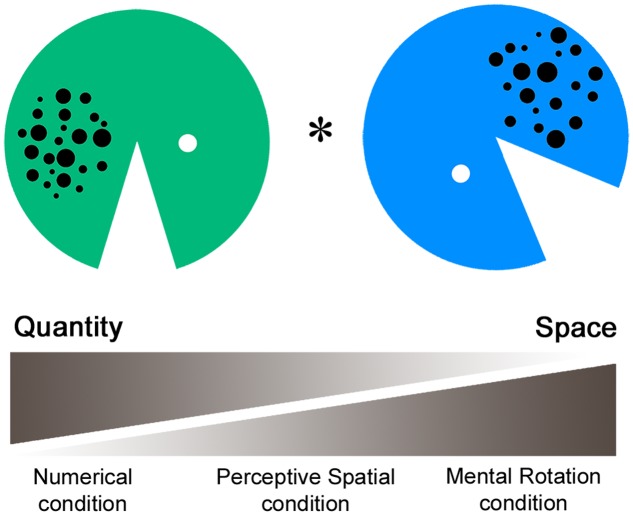
Functional magnetic resonance imaging paradigm. In the fMRI paradigm a green and a blue Pacman with varying arrays of dots, mouth size, and rotation angles were presented simultaneously. In the Numerical condition participants had to indicate which Pacman holds more dots, requesting a decision about discrete quantity. Secondly, in the Perceptive Spatial condition participants had to indicate which mouth was bigger, requesting a continuous magnitude and spatial decision. Thirdly, in the Mental Rotation condition participants were asked if the Pacman would face toward each other when rotating to an upright position, requesting a mainly spatial decision. Finally, in the control condition subjects had to indicate which Pacman was green.